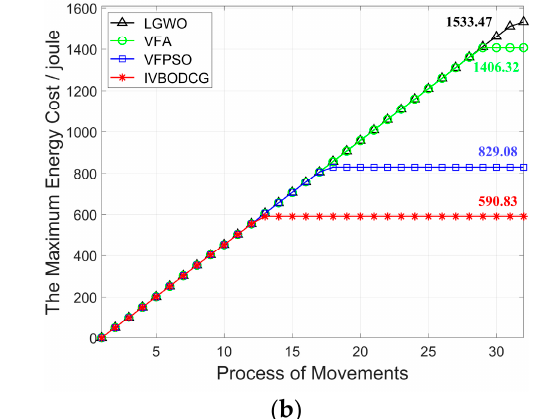
Figure 12. Energy cost for 53 sensors of IVBODCG, VFPSO, VFA and LGWO. The yellow, green, light blue, and dark blue bar graphs are the energy cost of the 53 nodes of four algorithms, respectively, after redeployment. The bars from right to left in a given bar graph represent the energy cost of nodes 1–53 of the corresponding algorithm.